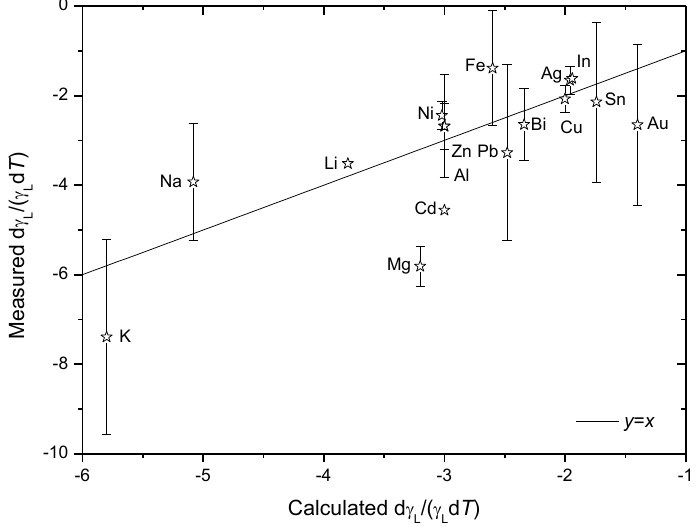
Figure 7. Comparison of measured temperature coefficient of surface tension dγ L /(γ L d T ) [33] and those calculated according to Equation (9) by using reported thermal expansion data for liquid metals [33]. Inaccuracies are large in the measured dγ L /d T and for most elements a value range was given. Plotted in this figure are the average of the maximum and minimum (indicated by error bars) of the given value